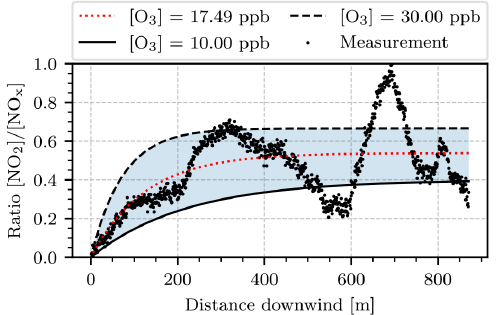
Figure 19. Plot of the [ NO 2 ] / [ NO x ] ratio as a function of distance traveled downwind, measured from the point at which the fully con- densed part of the plume ended (at a width of 840m in Fig. 14). The black scatter points represent the concentration ratio obtained on the basis of the camera data. The black solid and dashed lines show pre- dictions of the Janssen model for different ozone mixing ratios and a wind speed of v = 0 . 94ms − 1 . The dotted red line is a fit of the Janssen model to the measured data